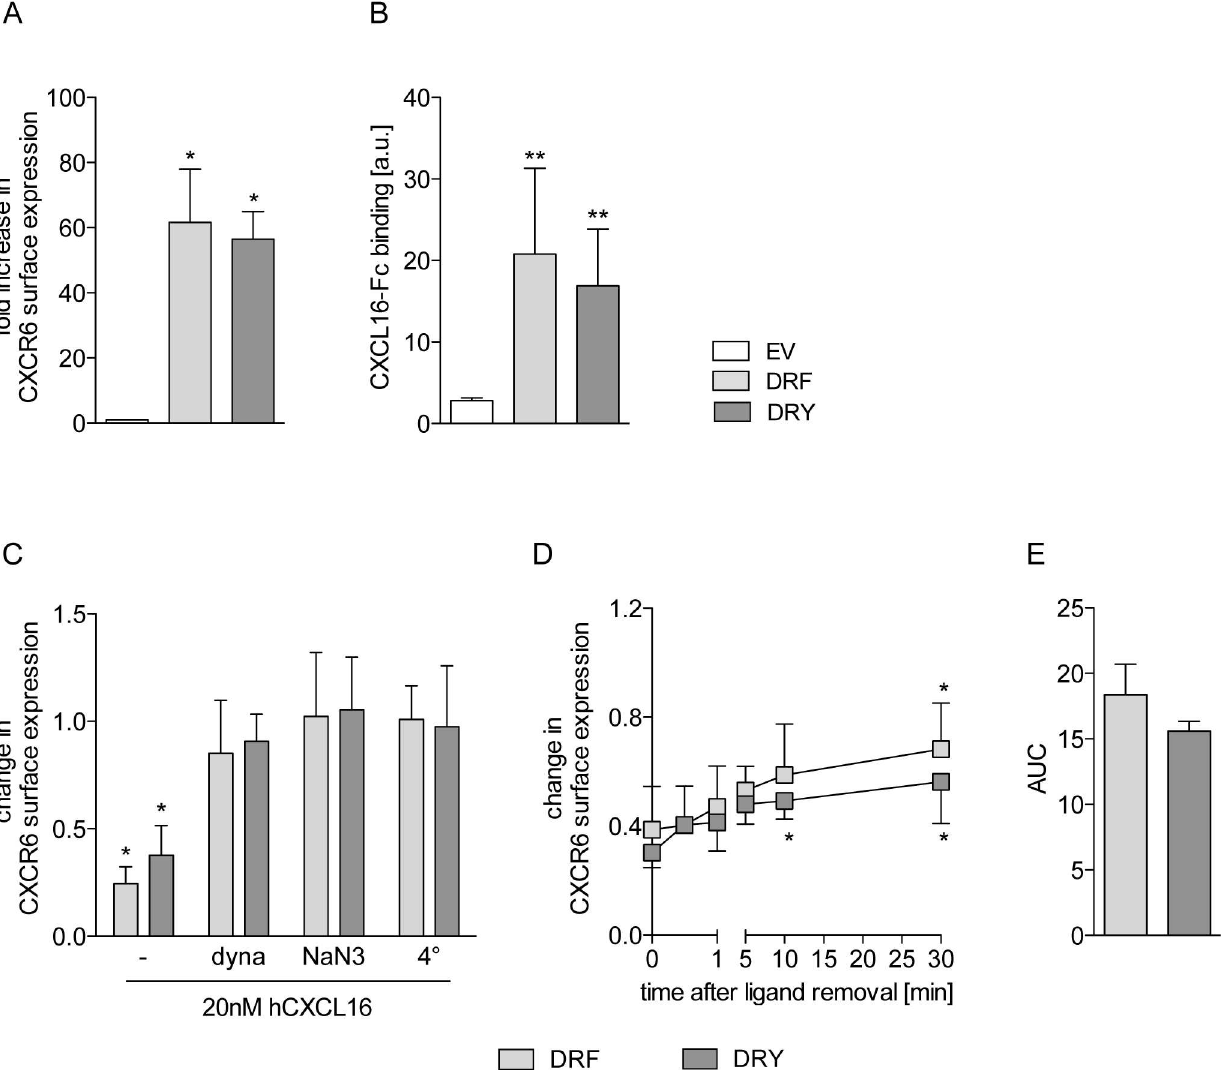
Fig 2. Rescue of the DRY motif in CXCR6 does not affect ligand binding or receptorrecycling in HEK293 cells. HEK293cells were transduced with lentivirus encoding the humanCXCR6 variants or the EV control. A/C-E: Surface expressionof CXCR6 in untreated cells (A, n = 4), after receptor internalization inducedby 15 min treatment with solubleCXCL16(C, n = 3), and receptorrecycling (D, dyna = dynasore, n = 4) was determinedby FACS analysisusing an antibody againsthumanCXCR6. Signalswere expressedin relationto control (EV in A, untreatedcells in C/D). Receptor recyclingwas further quantified as area under the curve of data shown in D (AUC, E). B: Ligandbindingwas analyzedby incubation with CXCL16-Fc fusion protein and FACS analysis(n (cid:21) 3, a.u. = arbitrary units). Statistical differenceswere analyzedby one-sample t-test (A and C, hypothetical value 1) or Student’s t-test (B, D and E). Asterisks indicatedifferencesto control ( * p < 0.05, ** p <